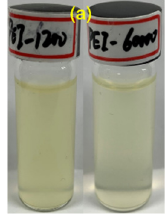
Figure 3. ( a ) Images of PEI1200- and PEI60000-coated ultrasmall Ho 2 O 3 nanoparticles in aqueous media (vials on the left and right-side, respectively) with a concentration of ~30 mM Ho. ( b ) DLS